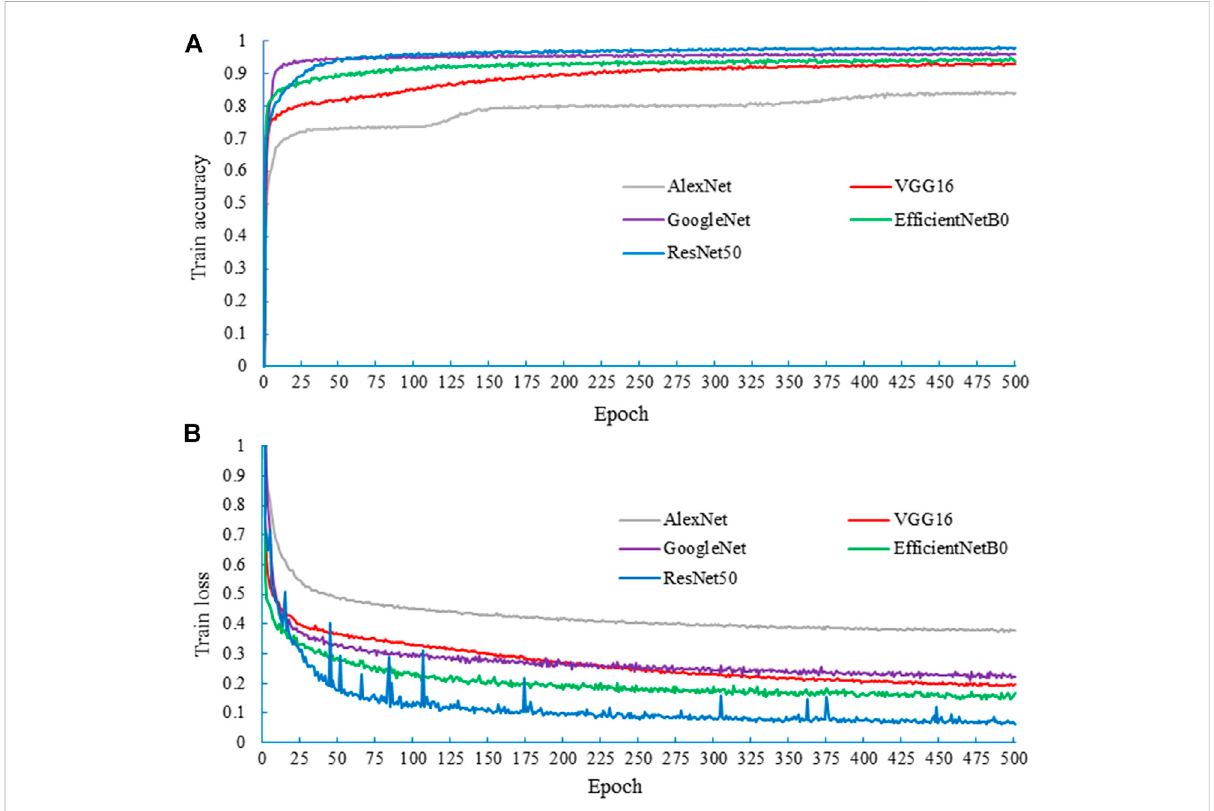
FIGURE 7 The training results of the spring network model, where (A) is the accuracy of the training process and (B) is the loss of the training process.